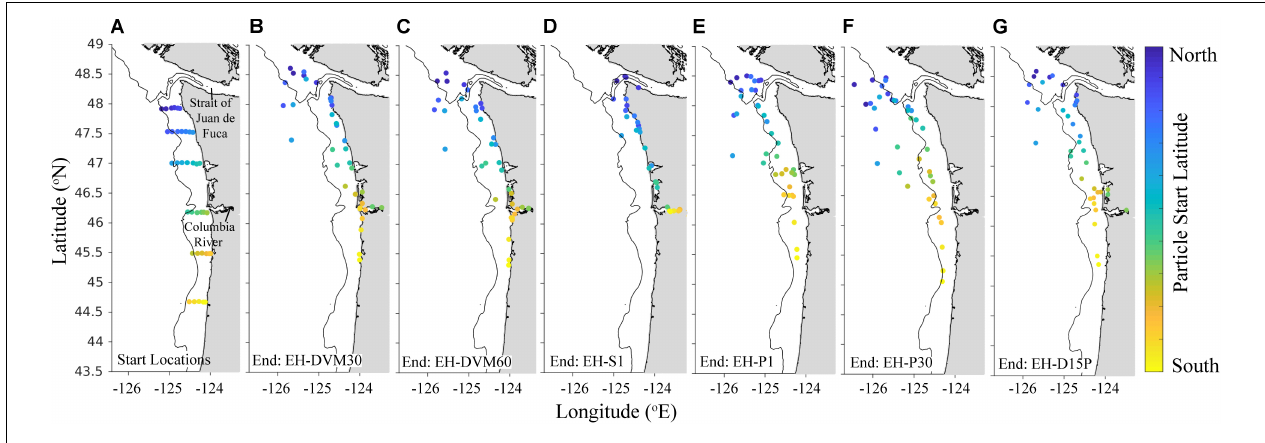
FIGURE 4 | Particle start (A) and average back-tracked origination locations (B–G) after 30-day simulated backtracking for particle exposure history simulations (2009–2017) that varied by behavior and initialization depth: DVM behavior from the surface to 30 m (EH-DVM30; B ) and 60 m depths (EH-DVM60; C ); the surface-following behavior (EH-S1; D ); passive particles initialized at 1 m (EH-P1; E ) and at 30 m depths (EH-P30; F ); and DVM transitioning to passive dispersal at day 15 (EH-D15P; G ; see Table 2 for details about exposure history experiments). Particles were initialized at the same 37 sampling stations. Back-tracked origination locations were averaged for all 100 particles initialized at each station, which sometimes resulted in the average origination location being on land; these particles were moved to the nearest shoreline. Initialization locations are uniquely colored for improved resolution of differing dispersal patterns across the spatial domain. Land is shaded gray, and the 200 m isobath is shown for reference.